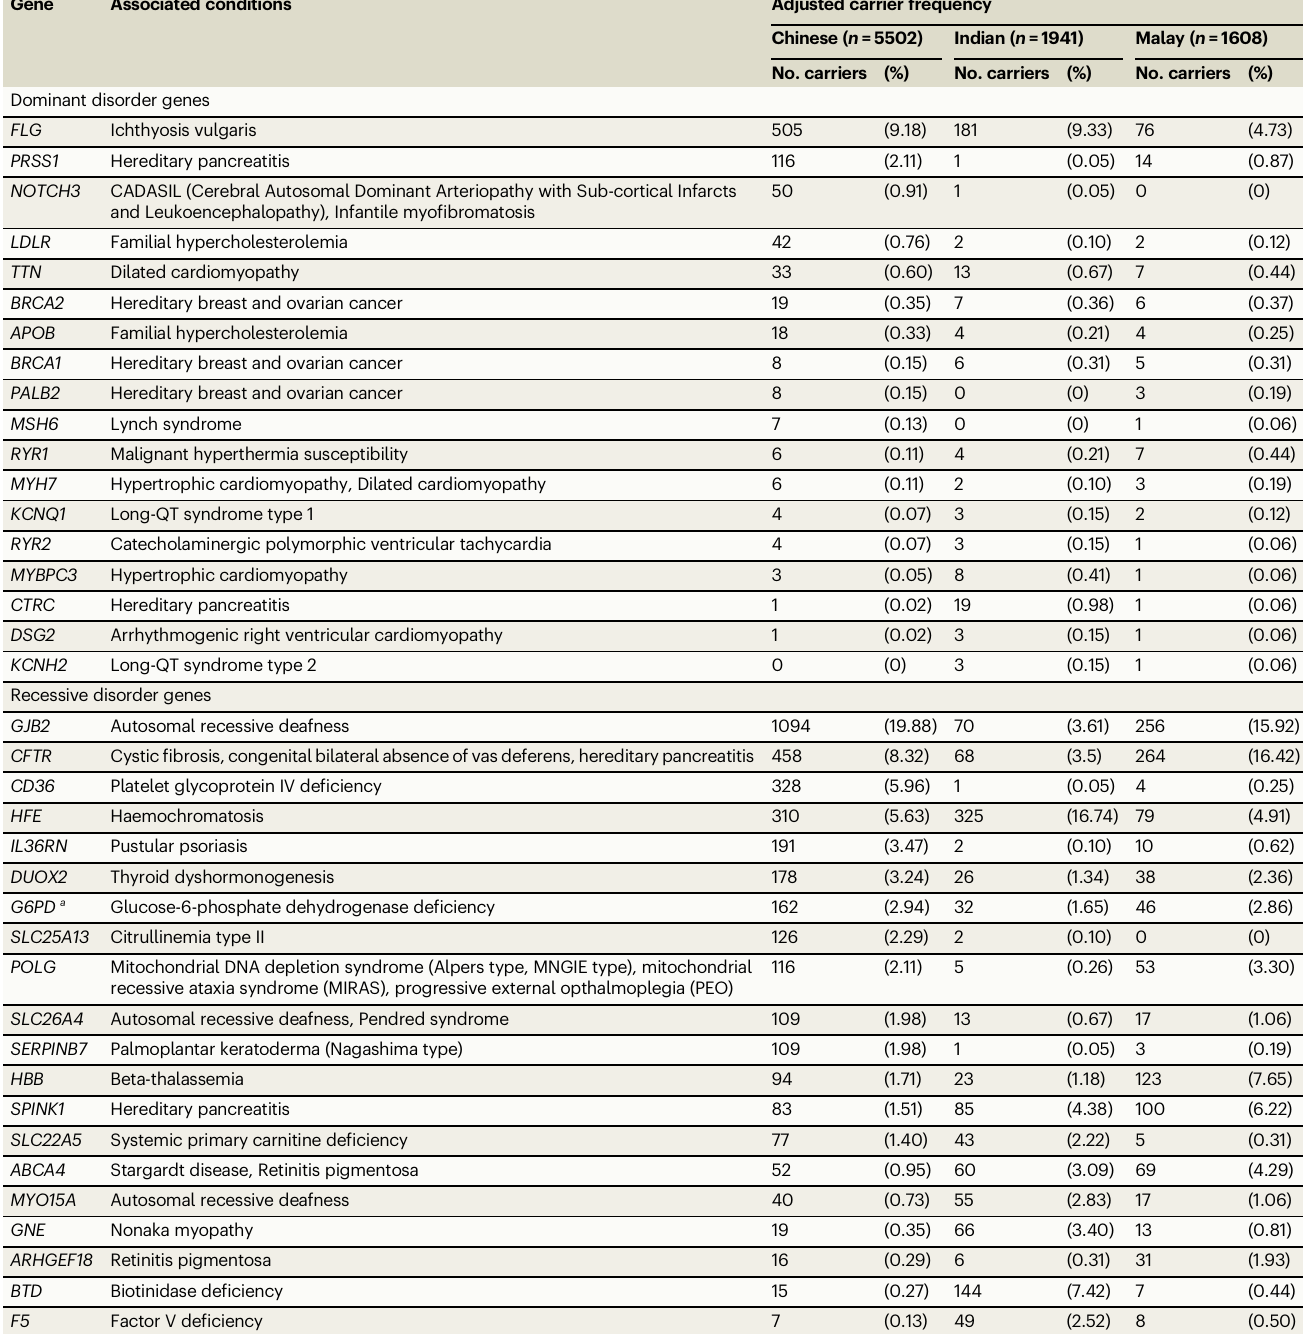
Table 1 | Consolidated top 10 autosomal dominant and autosomal/X-linked recessive disorder genes with highest carrier frequencies of P/LP variants identi fi ed in each ancestry group in